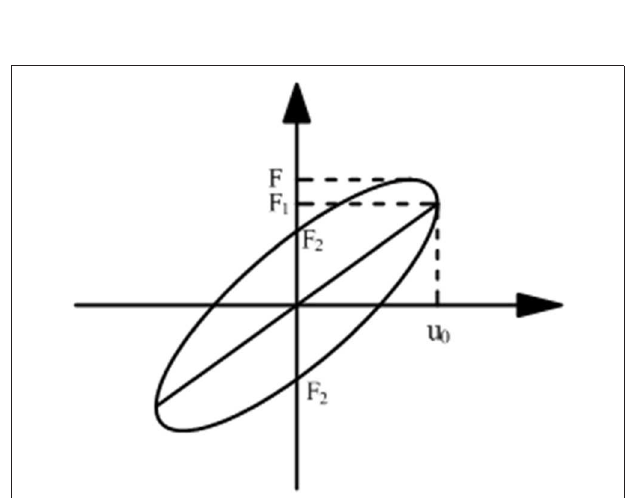
FIGURE 4 | Force-displacement hysteresis